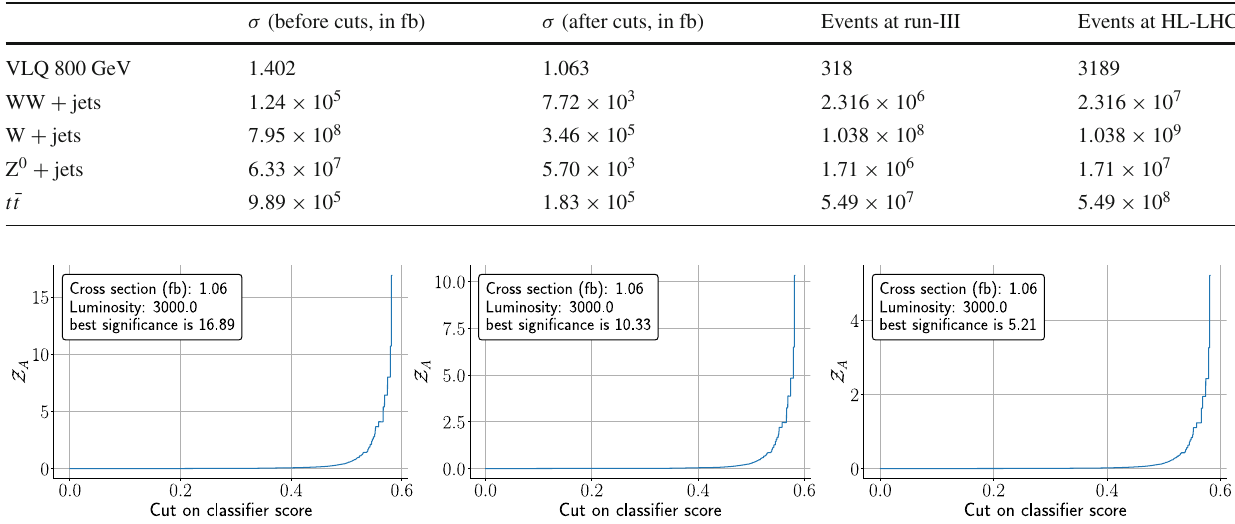
Fig. 5 ThestatisticalsignificanceforahypotheticaldiscoveryofVLQs asafunctionoftheNNscorefordifferentvaluesofthesystematicuncer- tainties considered in this work. The VLQ mass is 800 GeV, and the collider luminosity is L = 3000 fb. The significance is computed fol- Fig. 6 The statistical significance as a function of the systematic uncertainties for pair-production of 800 GeV D -VLQs. The green curve corresponds to σ b = 50%, the red curve – to σ b = 25% and the blue line – to σ b = 15%. There are two vertical dashed lines marking the run-III luminosity (300 fb − 1 ) and the HL-LHC luminosity (3000 fb − 1 ).